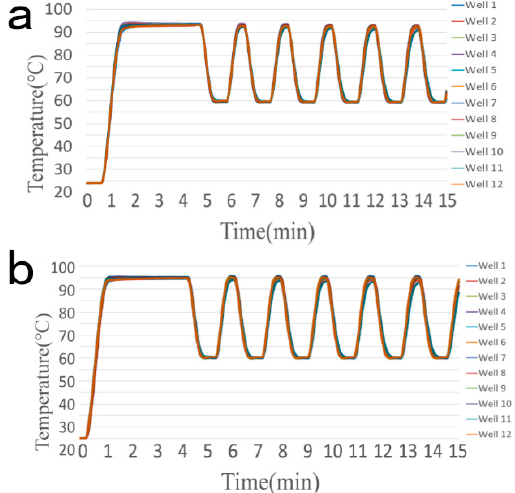
Figure 2. Temperature Curve of the Commercial PCR Amplification Program. ( a ) Before upgrade (the pre-denaturation step at 95 °C for 3 min, the denaturation step at 95 °C for 15 s, and the annealing/extension step at 60 °C for 35 s); ( b ) After the upgrade (the pre-denaturation step at 96.8 °C for 3 min, the denaturation step at 97.2 °C for 15 s, and the annealing/extension step at 60.5 °C for 35 s).